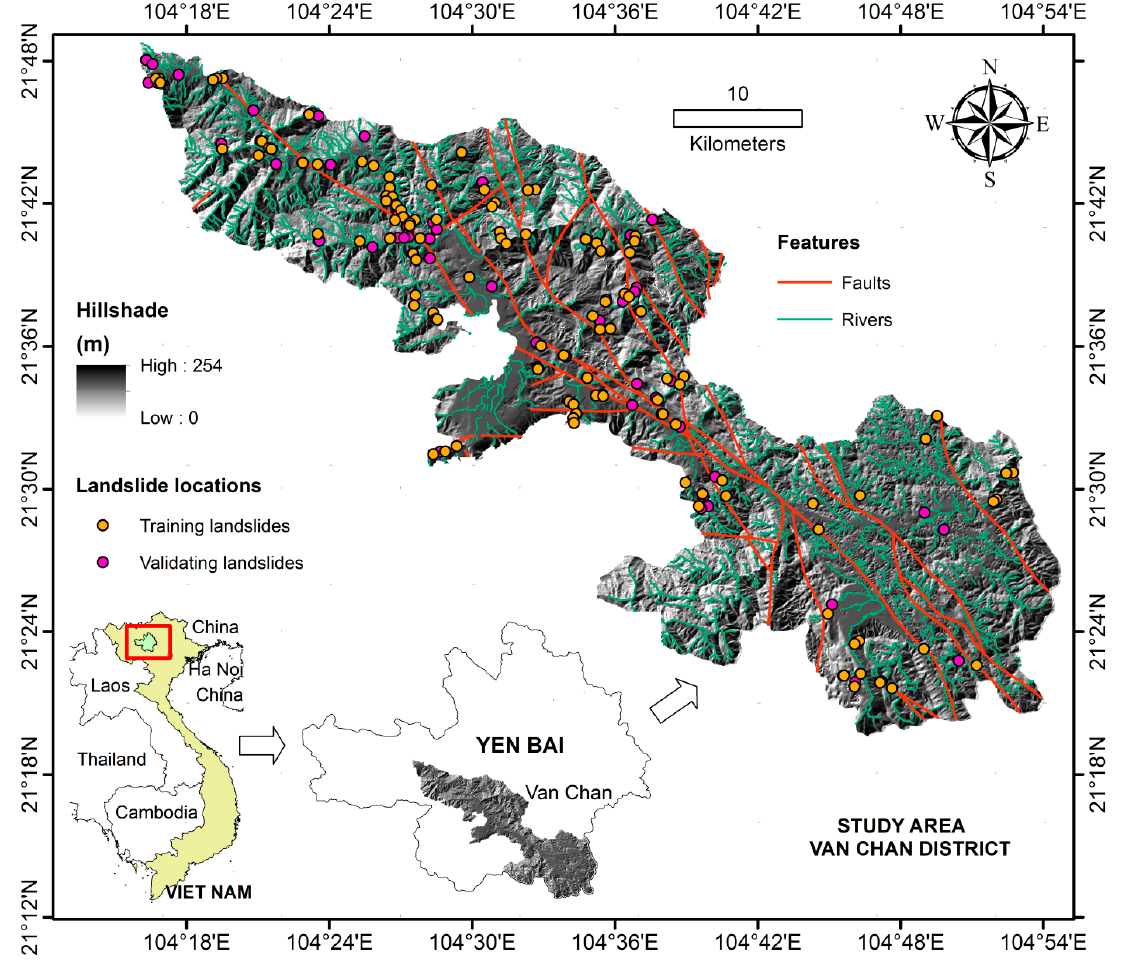
Figure 1. Location of the Van Chan district, Vietnam.